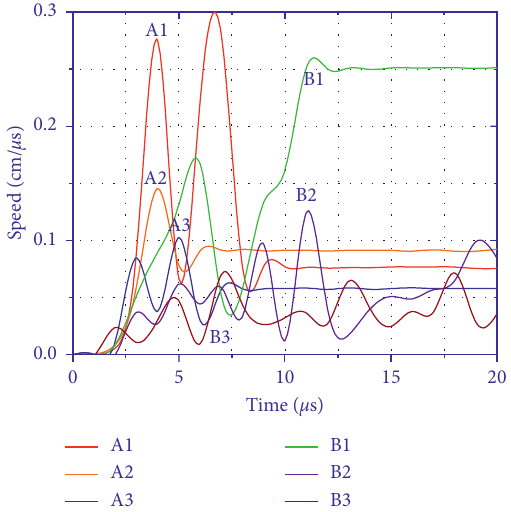
Figure 19: Joint velocity curve of shaped charge hydraulic blasting.